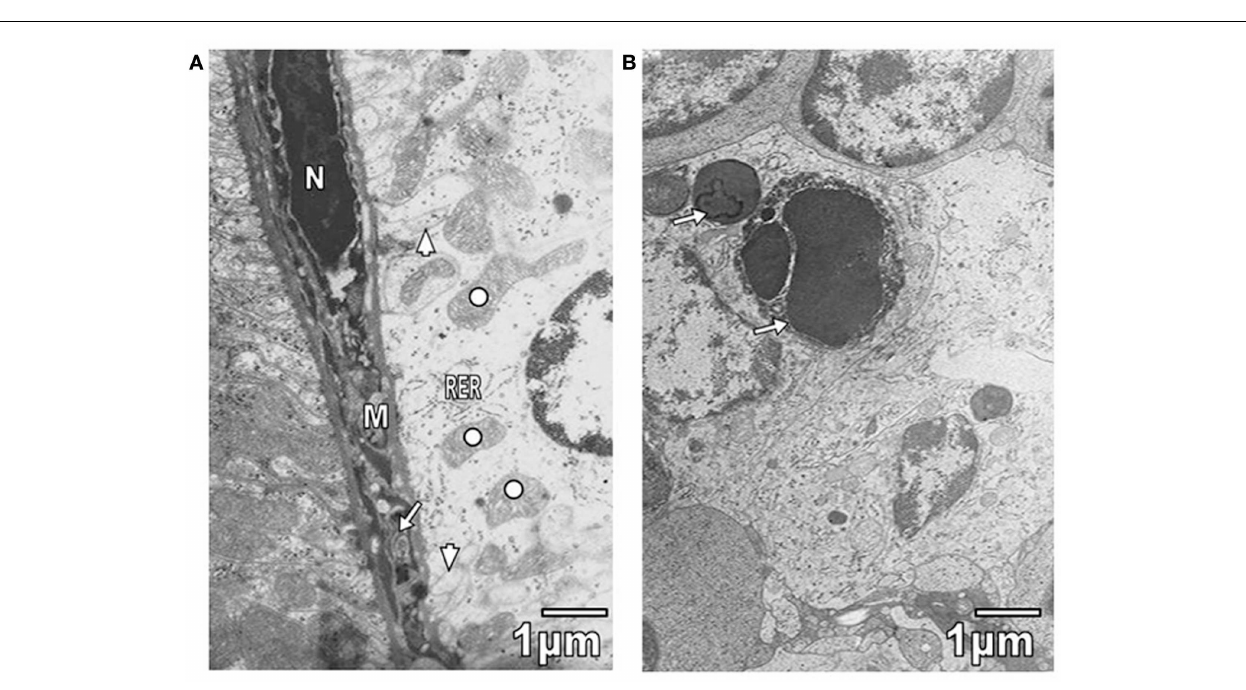
capillary, swollen RER (arrow), mitochondria (M), and hyperchromatic nucleus (N) are seen. (B) Section of spleen from parasitized mouse with T. evansi is shown. Note the presence of apoptotic bodies (arrows).